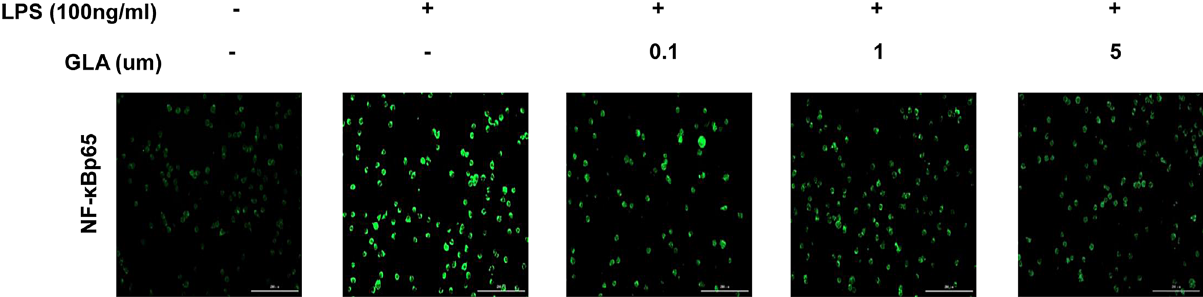
Figure 12: E ff ects of GLA on NF - κ Bp65 nuclear translocation in RAW264.7 cells. The expression level of NF - κ Bp65 in the LPS - stimulated RAW264.7 cells, in the presence or absence of GLA ( at indicated concentrations ) , was detected with immuno fl uorescence ( 200 ×) . The experiments were repeated at three